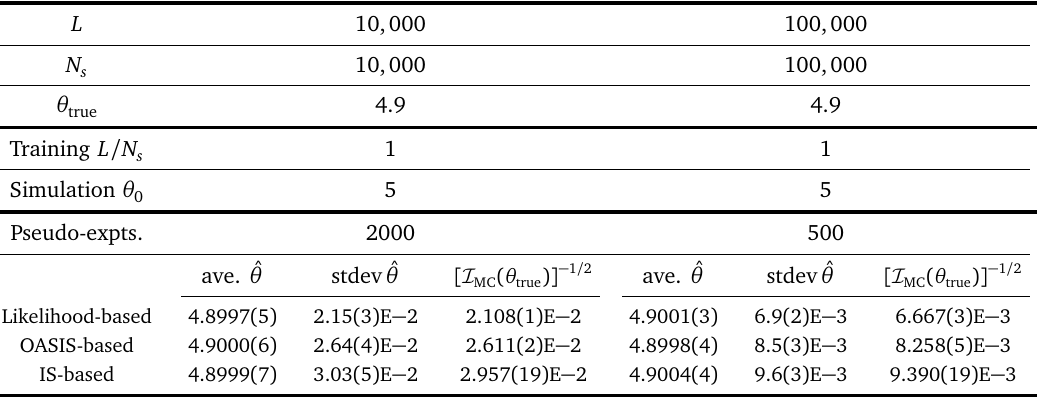
Table 2: Simulation parameters and summary statistics of the results from the simu- lated pseudo-experiments to measure θ true